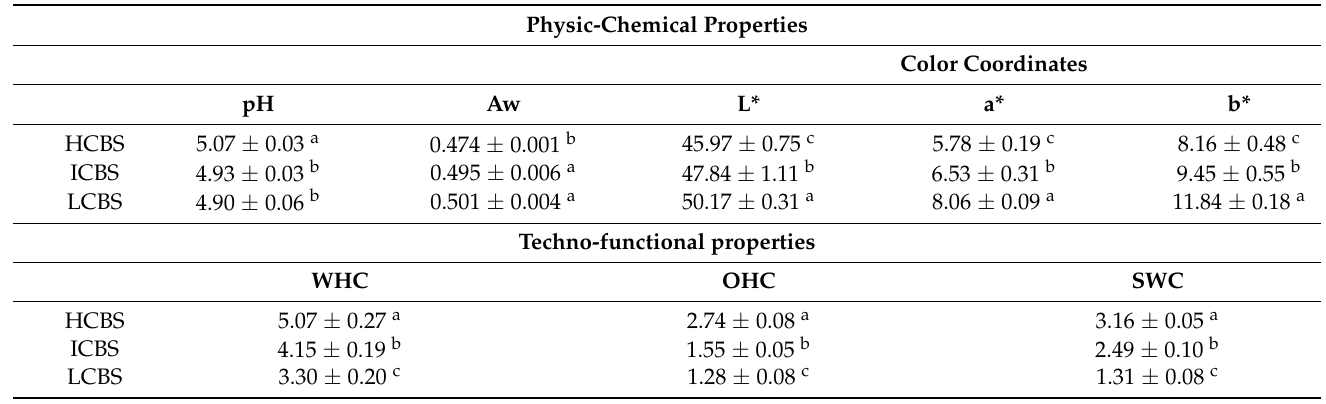
Table 3. Effect of particle size on physico-chemical and techno-functional properties of cocoa bean shell flours. Physic-Chemical